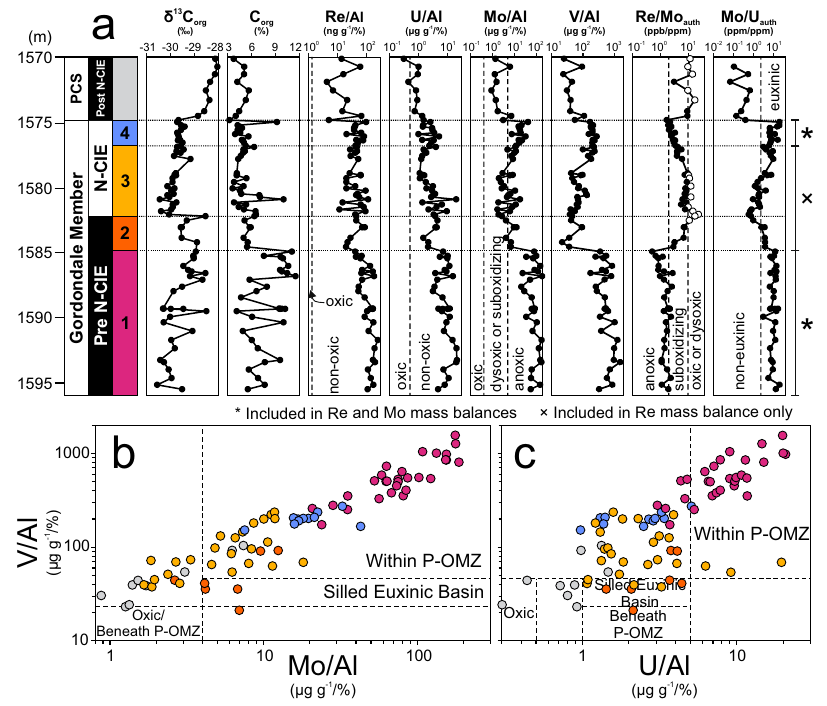
Fig. 2 | Geochemical data for the c-B6-A/94-B-8 core hosting T-OAE deposits. Gordondale Member core ( a ) geochemical pro fi les, ( b ) V/Al versus Mo/Al covar- iation, and ( c ) V/Al versus U/Al covariation. The Toarcian Oceanic Anoxic Event is classically recognized by a negative carbon isotope excursion (N-CIE), which is observed in the organic carbon fraction ( δ 13 C org ) between 1575.00 and 1582.10m depth. Trace metal/Al, and authigenic (auth) Re/Mo and Mo/U ratios are used to characterizethelocaldepositionalredoxconditionsandselectsuitablesamplesfor global Re and Mo mass balance models. Thresholds for each proxy are shown as